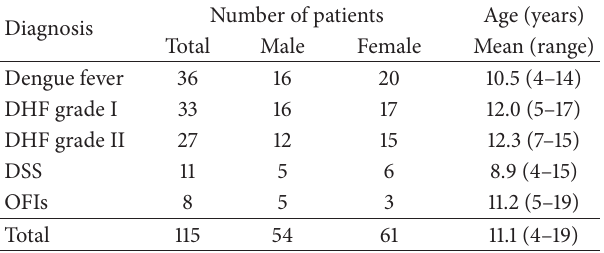
Table 1: Clinical diagnosis and demographic information of studied